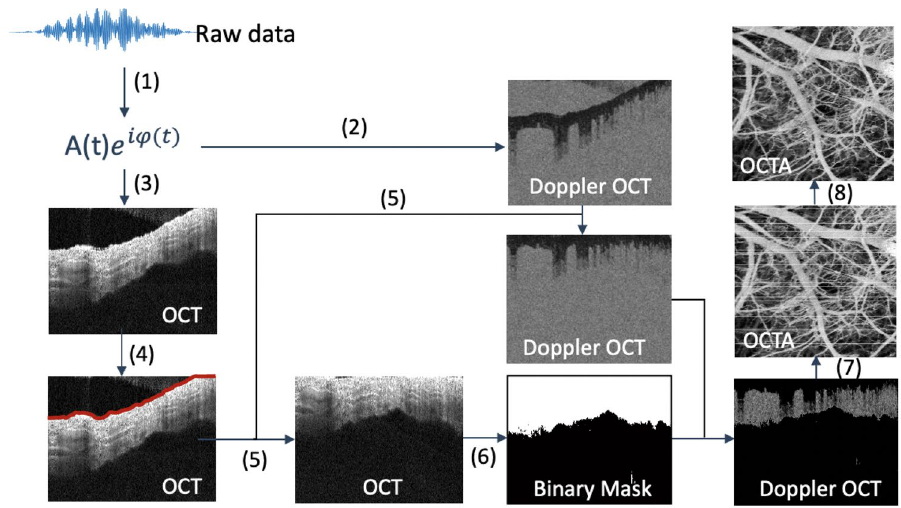
Figure 6. Flow chart of OCTA algorithm. (1) Hanning window and FFT. (2) Intensity-based Doppler variance method to extract blood vessel. (3) OCT image. (4) Edge detection based on OCT image. (5) Flatten image target surface. (6) Generate a binary mask to remove background from Doppler image. (7) Scanning. (8) Bulk motion removal using a low pass